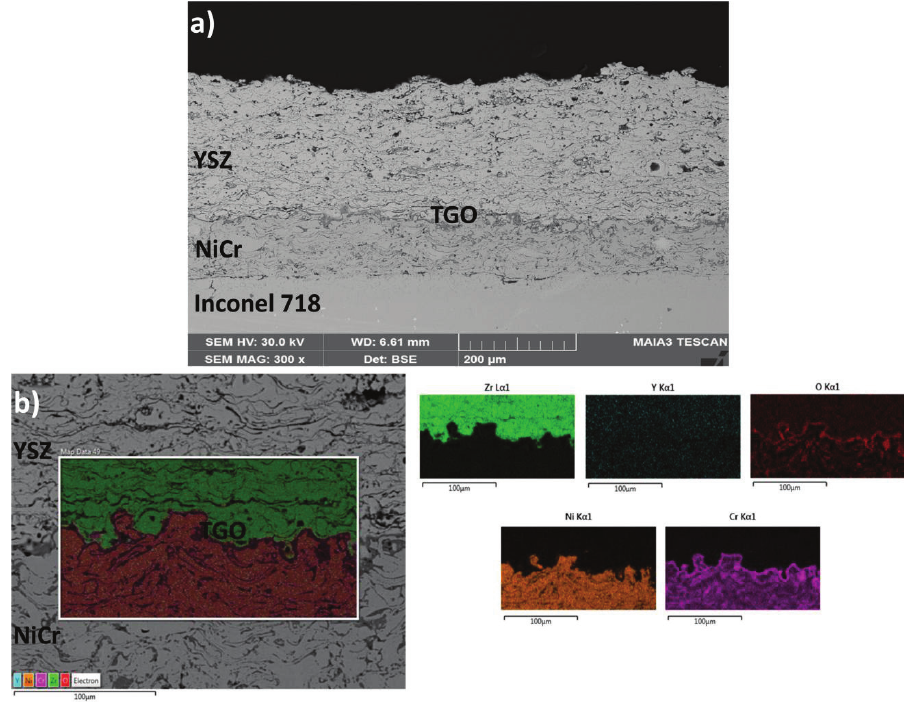
Figure 4: SEM and elemental mapping image of TBC oxidized for 50 h at 1000°C .